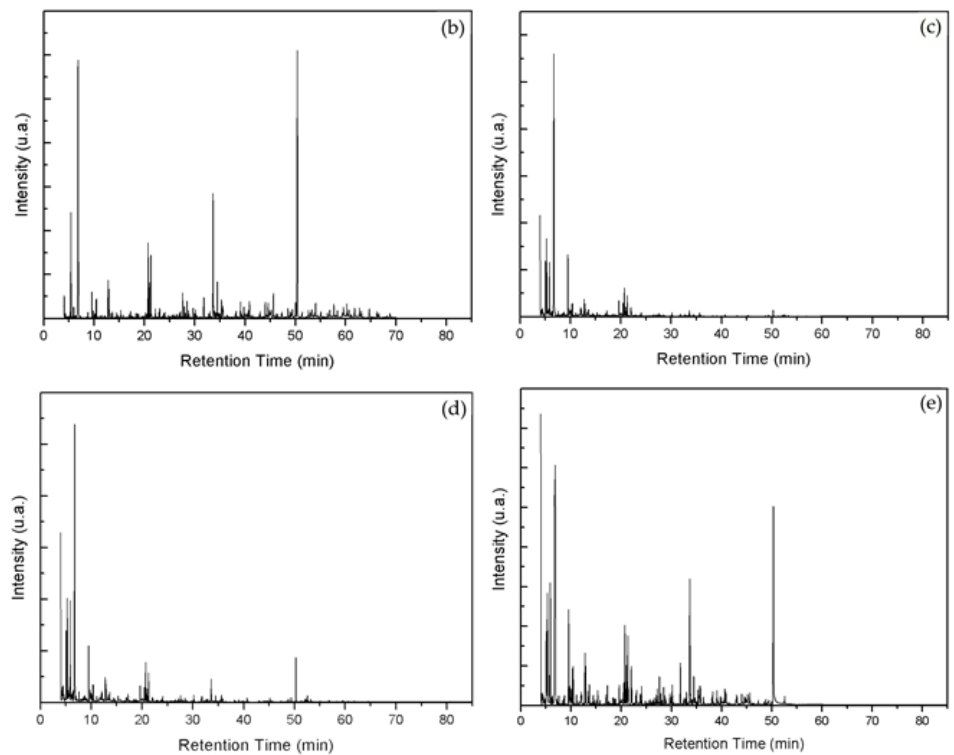
Figure 6. ( a ) Distribution of the pyrolysis products (gaseous, liquid, and solid fractions) of the PMix with different catalysts and the chromatograms of complete pyrolysis oil; ( b ) non-catalytic, ( c ) MOR/02, ( d ) MOR/SD, ( e ) ZSM-5/02.